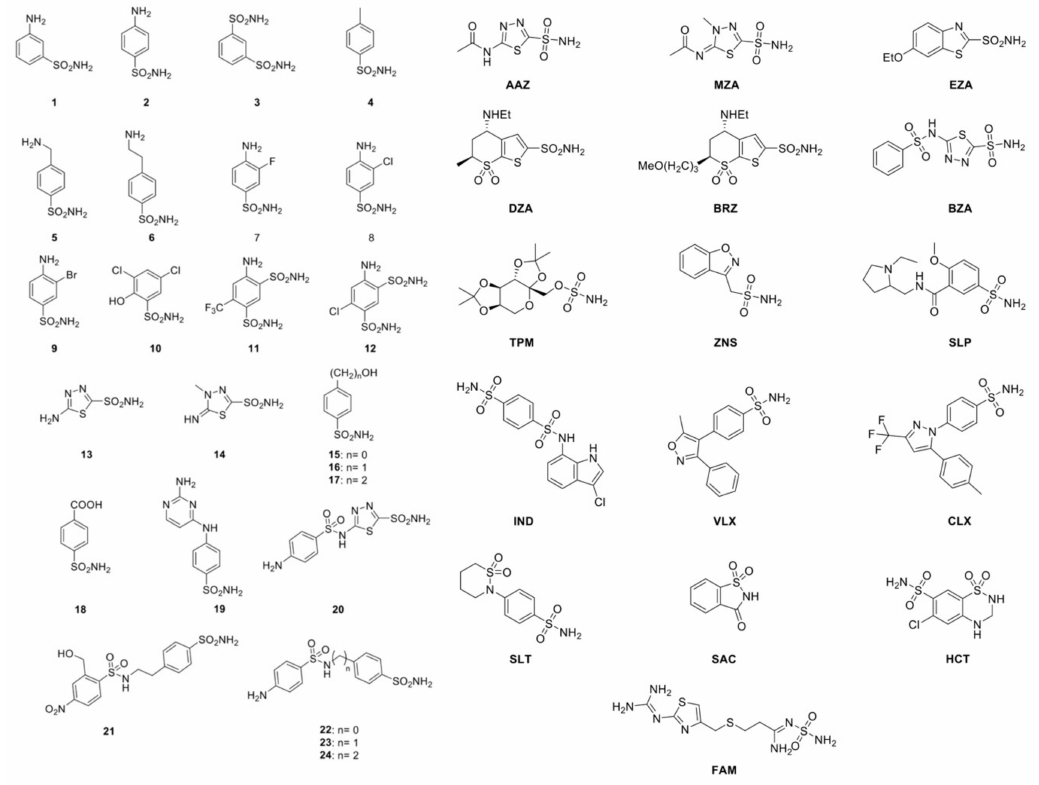
Figure 3. The 40 compounds. Thirty-nine sulfonamides and one sulfamate (TPM) were used to determine the MreCA inhibition